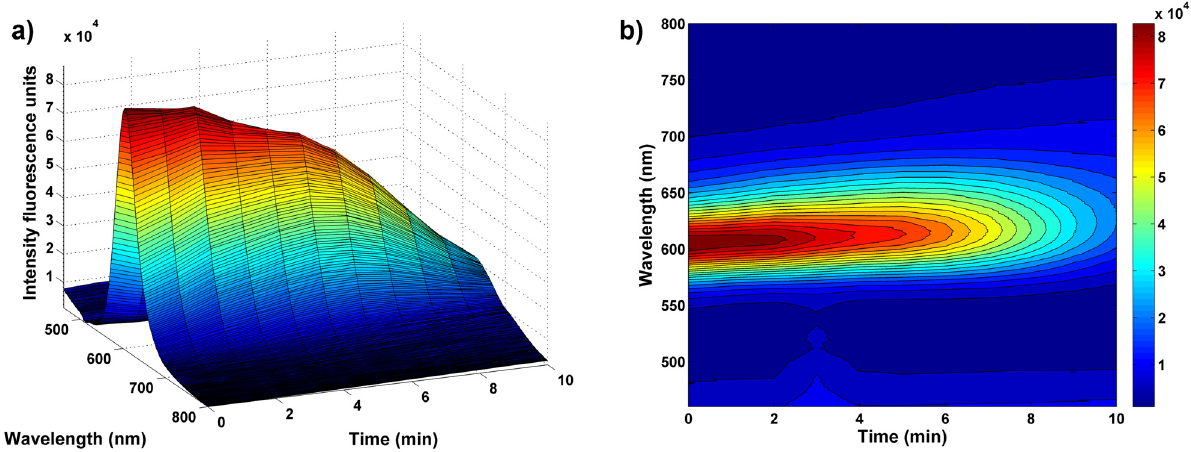
Figure 9. ( a ) Second-order data PL spectra between QDs and ASA standard of 35.6 mg L − 1 , and ( b ) the corresponding plot of the fluorescence emission as function of time and wavelength.